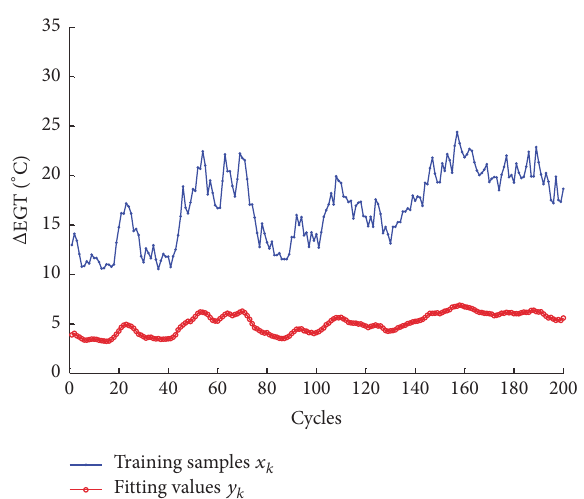
Figure 5: Position relation between fitting value 𝑦 𝑘 and training sample 𝑥 𝑘 under excessive underfitting.